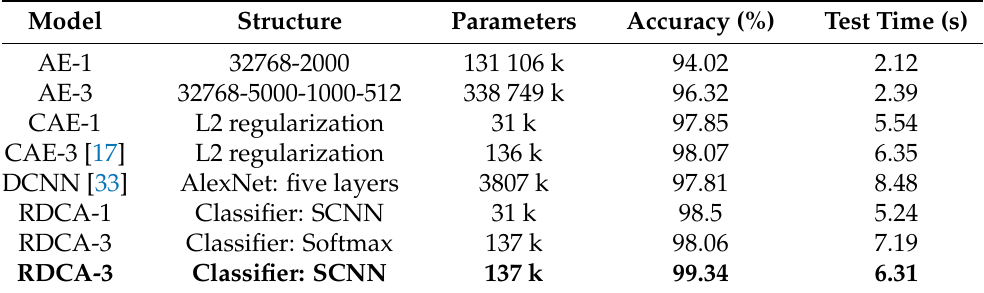
Table 2. Comparison of different feature extraction methods.